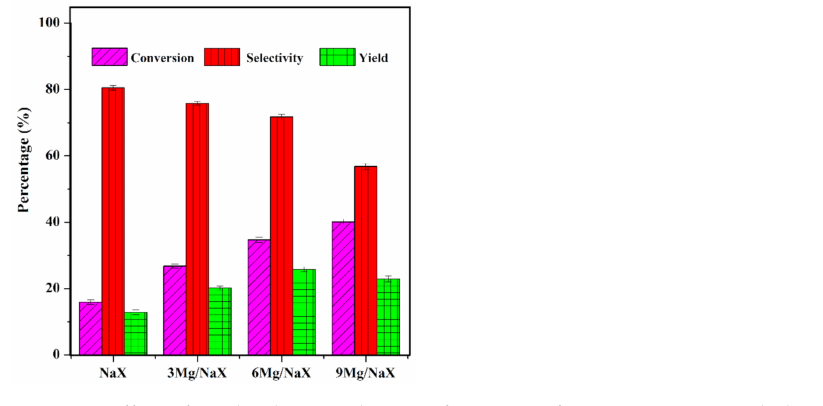
Figure 5. Effect of Mg loading catalytic performance of microwave-assisted glucose isomerization into fructose at 90 ◦ C for 15 min with the triplicate-repeated